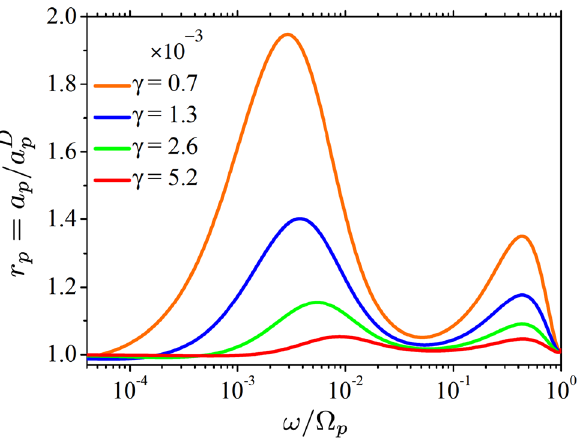
Figure 5. Relative absorptivity r p , calculated for selected values of the decay rate γ (shown in units of (cid:31) p ) for 60 incident angle θ ◦ =